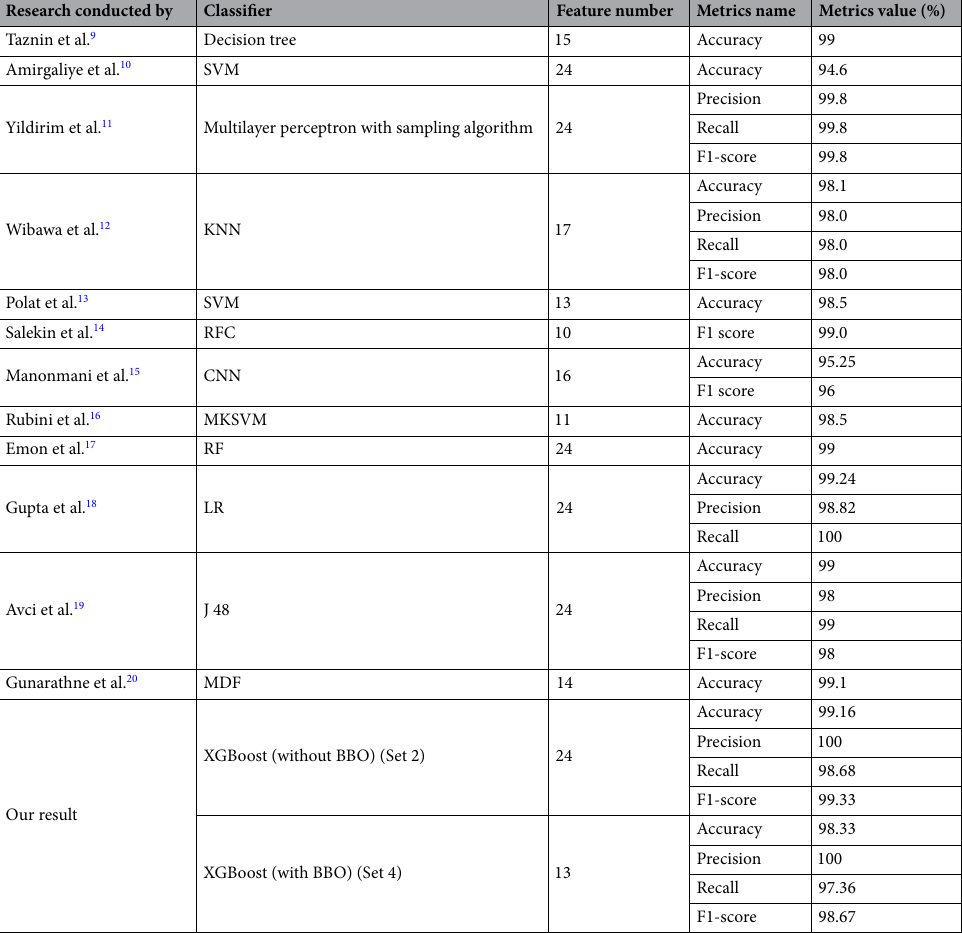
Table 6. Comparing results of other studies conducted on the same dataset.